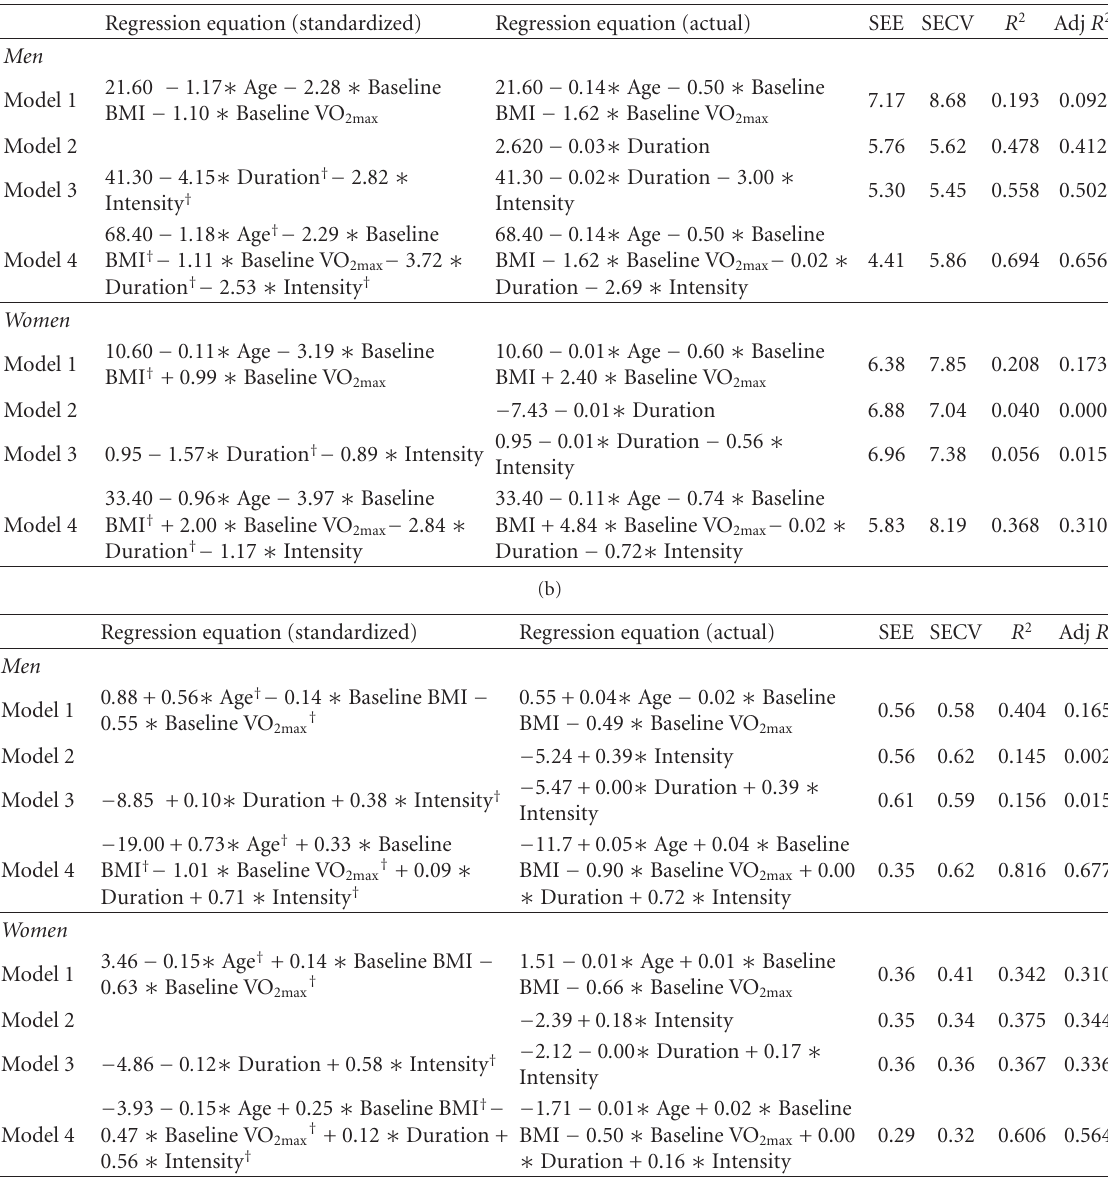
Table 2: (a) Regression equations, standard errors, and explained variance in change in weight. All models are cross-validated excluding every fourth subject. Independent variables that have a significant contribution ( P < . 05) to the model are labeled † . SEE: standard error of the estimate; SECV: standard error of the cross-validation. (b) Regression equations, standard errors, and explained variance in change in cardiorespiratory fitness. All models are cross-validated excluding every fourth subject. Independent variables that have a significant contribution ( P < . 05) to the model are labeled † . SEE: standard error of the estimate; SECV: standard error of the